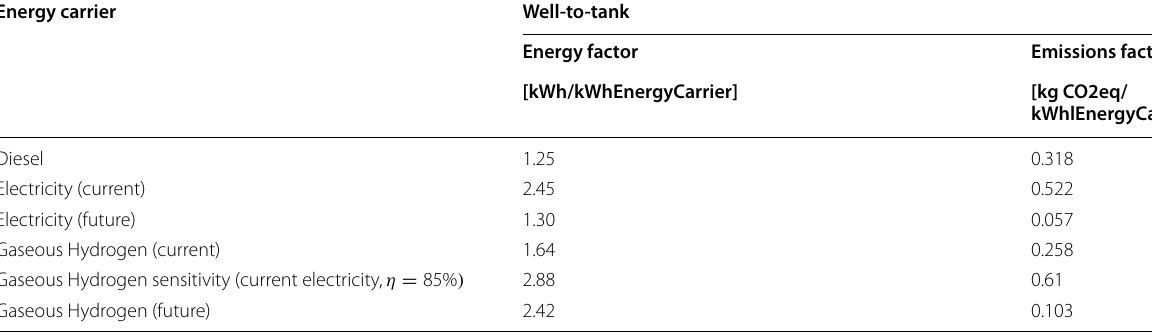
Table 3 Well‑to‑tank energy and emissions factors Energy